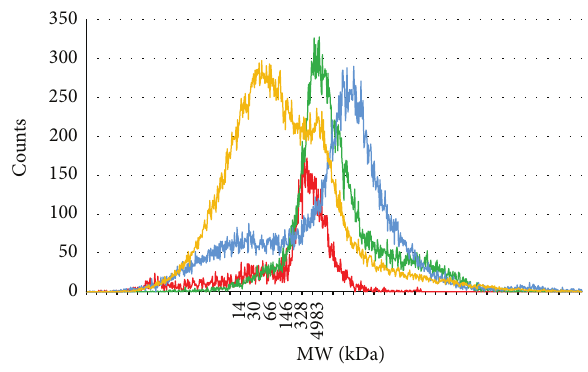
Figure 1: GEMMA data profile. Molecular size distribution of HA extractedfromfourdifferenttissuesandspecies,ratkidney(orange), chicken comb (green), human heart (blue), and moose heart (red), one of each. The electroforetic molecule diameter analyzed in the GEMMA was converted to molecular weight by analyzing HA standards from Hyalose L.L.C. ranging from 30 kDa to 2400 kDa samples [21]. HA from moose heart and chicken comb both showed uniform HMW HA peaks around ca 5000 kDa. HA from rat kidney showed the HMW peak and an additional broad peak with a center around 30 kDa. Human heart also showed presence of LMW HA in the same range as in rat kidney but the HMW HA content was of apparent greater size than the other three examples